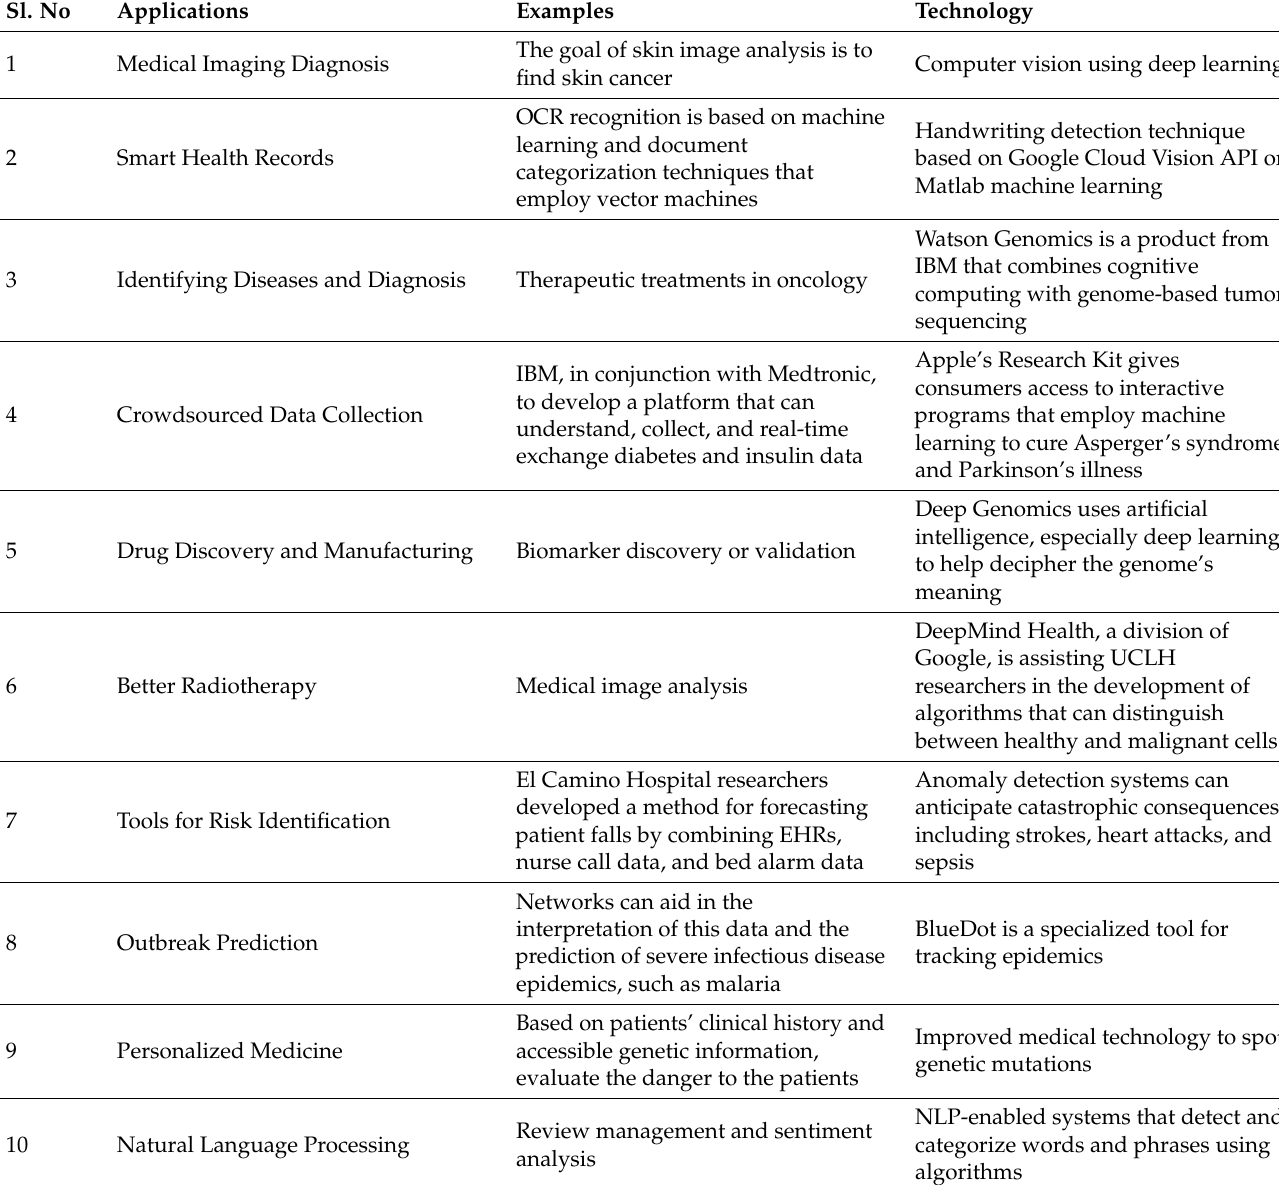
Table 1. Different types of machine learning applications in healthcare and global